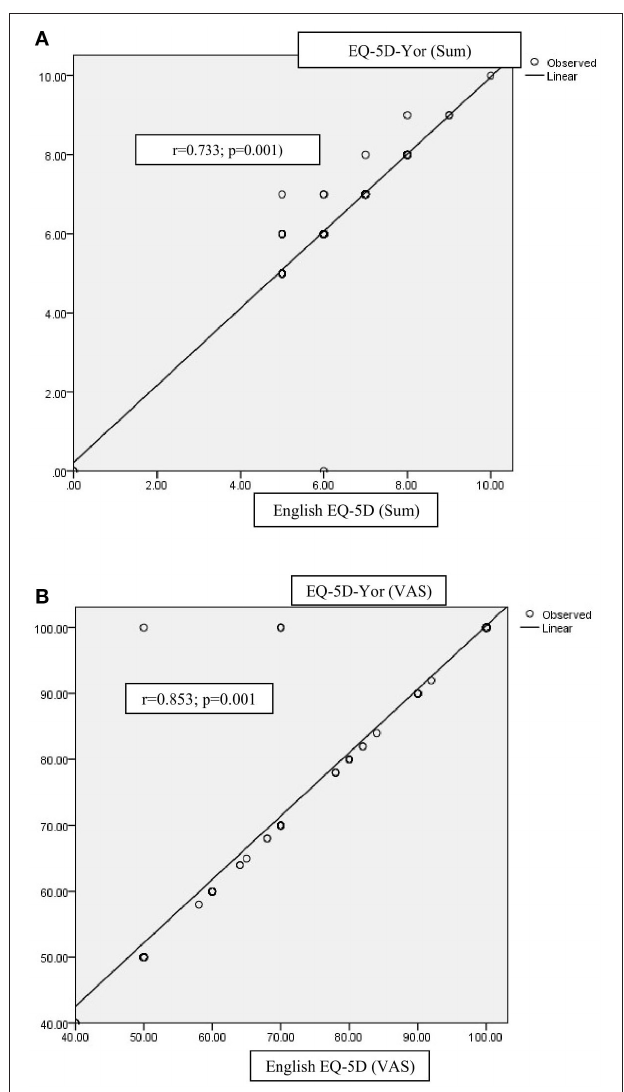
FIGURE 1 | (A) Scattered plot diagram depicting the concurrent validity of the EQ-5D-Yor. (B) Scattered plot diagram depicting the correlation between the EQ-5D-Yor (VAS) and the English